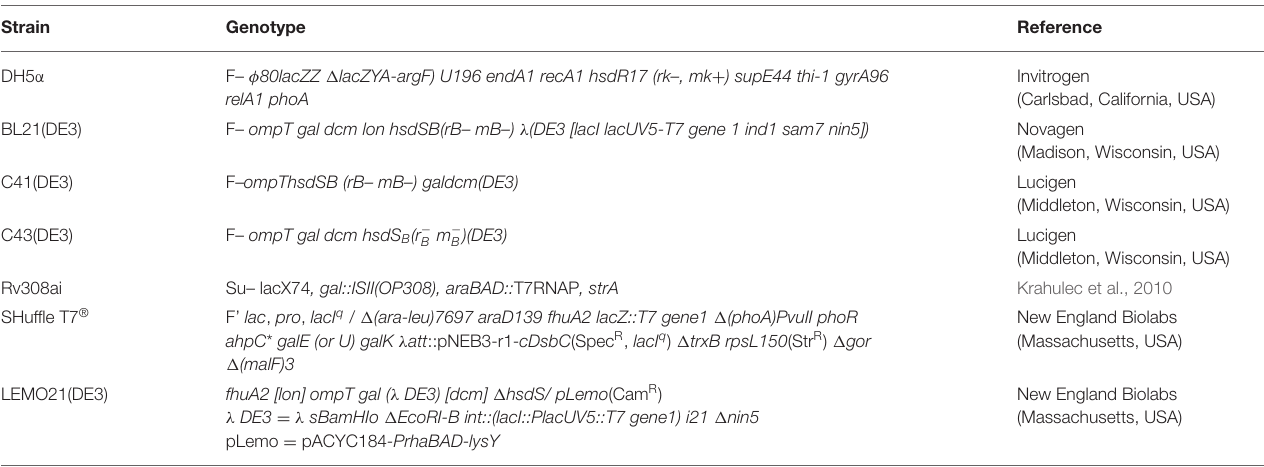
TABLE 1 | Escherichia coli strains used in this study. Strain